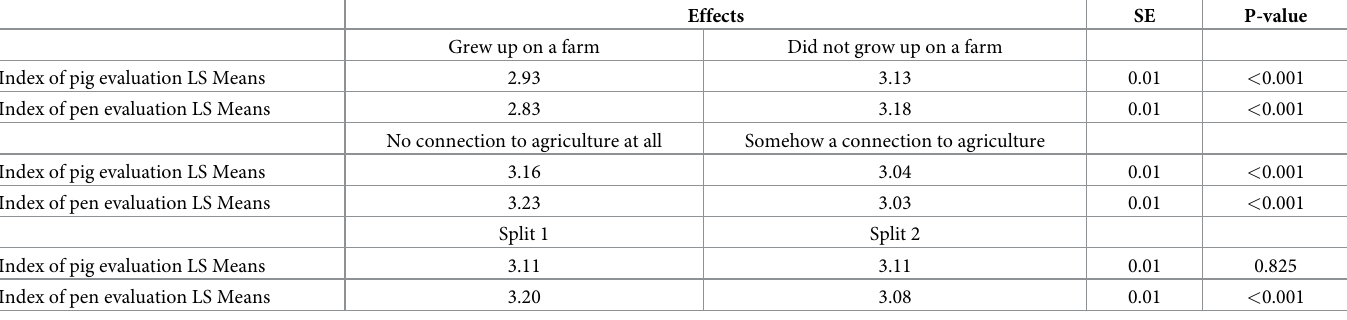
Table 9. Effects of growing up on a farm, connection to agriculture and picture order on pig and pen evaluation (1 = positive evaluation, 5 = negative evaluation) in the combined pictures showing a pig in a pen using LS Means comparison with